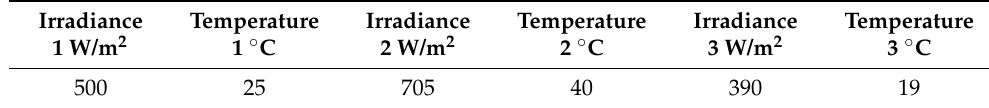
Table 6. Real working conditions used for validation.